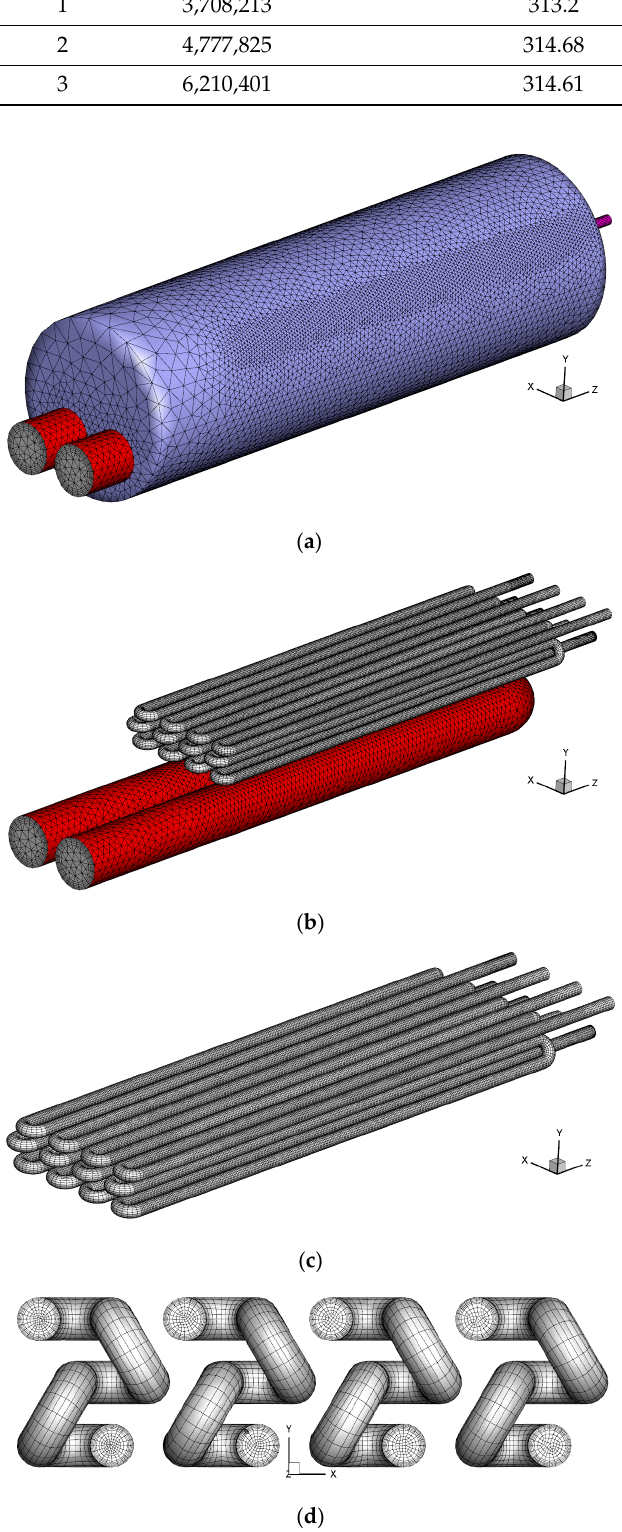
Figure 4. Various views of the generated grid for the heater under study: ( a ) shell, ( b ) fire tube and gas tubes, ( c ) close ‐ up of gas tube, and ( d ) different view of gas tubes.